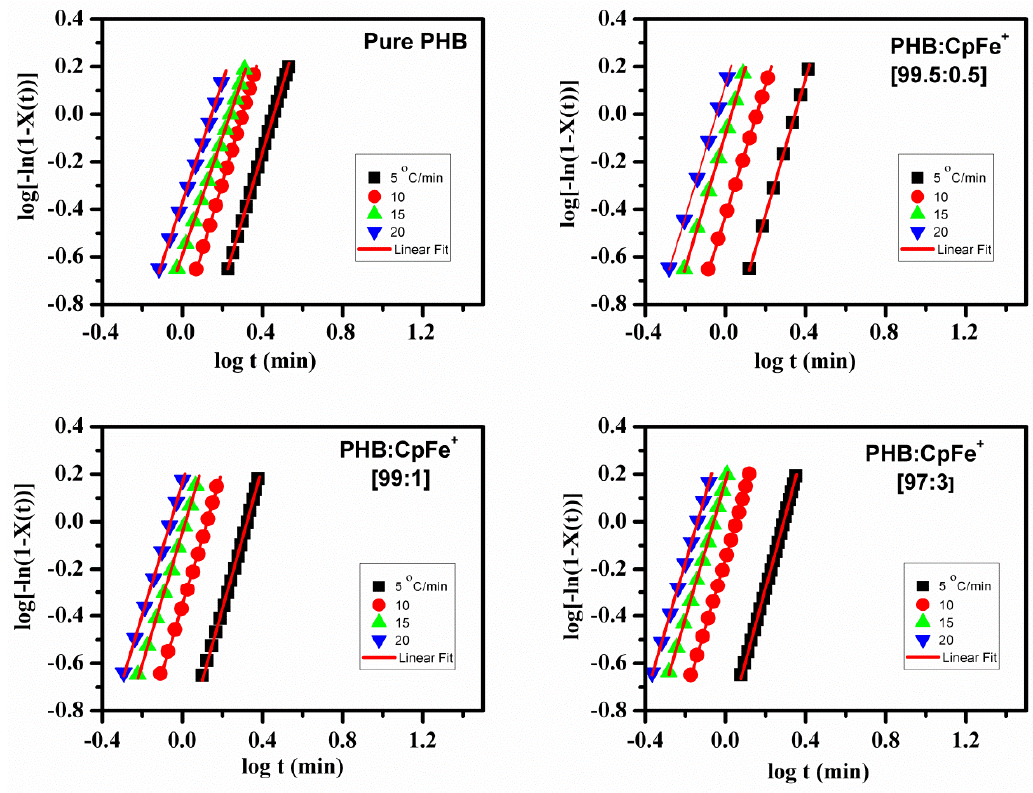
Figure 9. Typical Avrami plots of log ( 1 − ln ( 1 − X ( t )) versus log ( t ) of the pure PHB and PHB/CpFe + nanocomposites that non-isothermally crystallized at various cooling rates. Table 3. Non-isothermal crystallization kinetics parameters of the pure PHB and PHB/CpFe + nanocomposites based on the modified Avrami